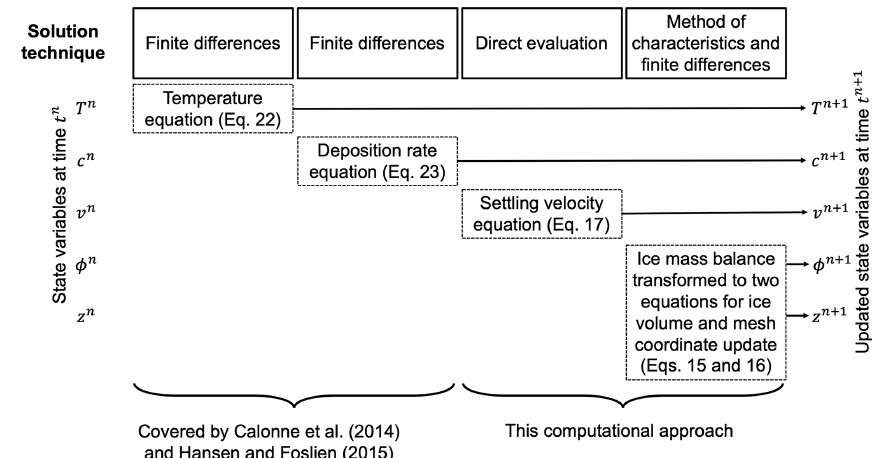
Figure 2. The computational workflow of one iteration. The state variables at time t n , depicted on the left-hand side, are updated through the modules annotated as dashed-outline boxes that are ordered diagonally in the center of the figure. After each update the state variables at time t n + 1 are retrieved. The equations of the modules are implemented into the computational model through the respective solution technique stated in the solid-outline boxes in the top row. The computational steps are carried out from top to bottom. The iterative approach can be summarized as (1) determine time step size (cid:49)t according to Eq. (26), (2) update the temperature field based on Eq. (22), (3) compute the deposition rate with the temperature field based on Eq. (23), (4) determine the vertical velocity with Eqs. (17) and (18), and (5) update the ice volume fraction and the mesh coordinates simultaneously based on Eqs. (19) and (20). While (2) and (3) are a re-implementation of an existing approach previously published by Hansen and Foslien (2015) and Calonne et al. (2014), their coupling to (4) and (5) constitutes the novelties of our work. Note that (4) is computed as part of (5) in the